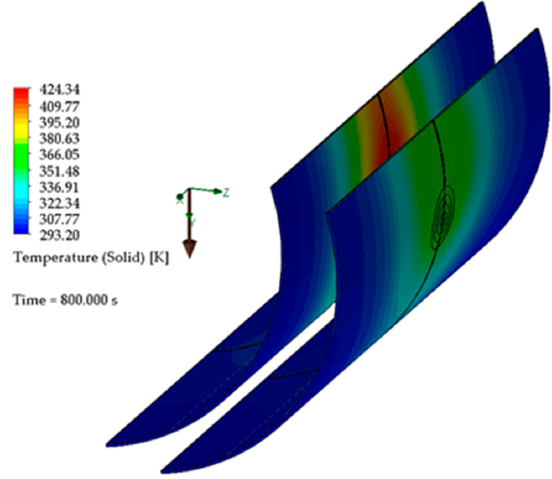
Figure 21. Temperature at 800 s.